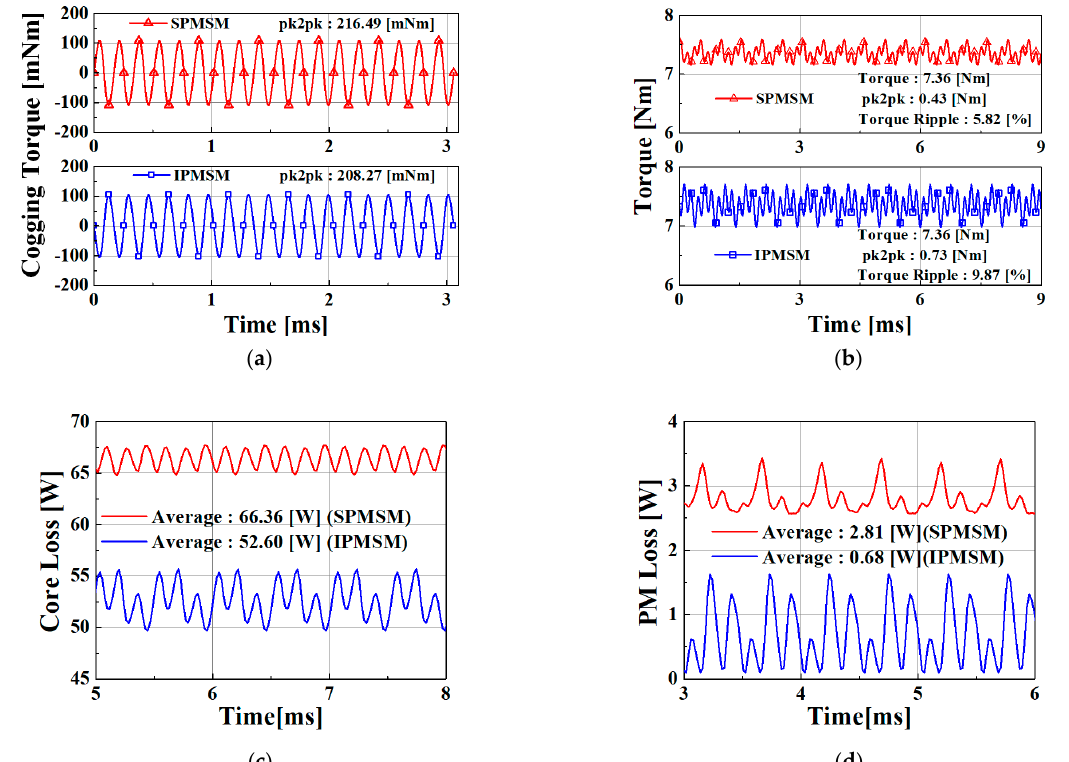
this is only a minor difference. The high back EMF THD of the IPMSM can be explained by